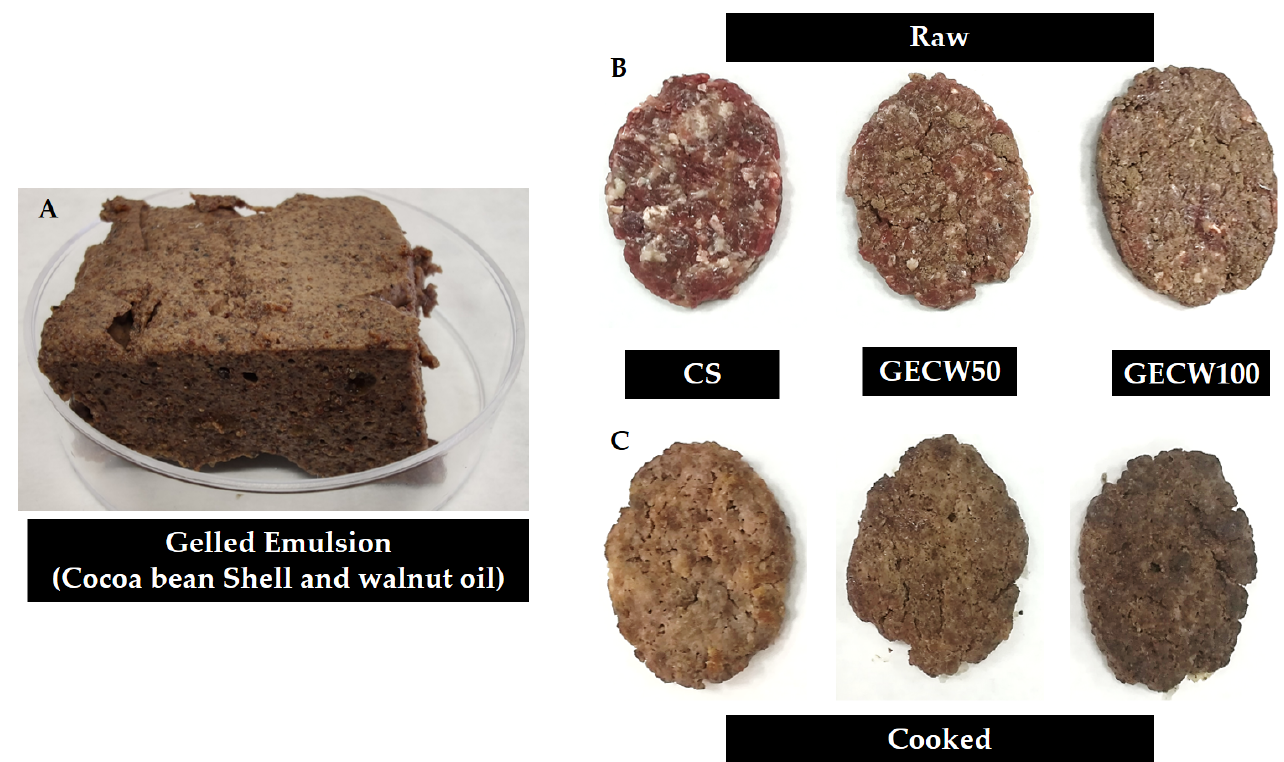
Figure 1. Beef burger made with a gelled emulsion as partial or total pork backfat replacer. ( A ): Gelled emulsion created with cocoa bean shell flour and walnut oil (GECW). ( B ): Raw burger made with 0% (CS: Control sample), 50%, and 100% GECW as fat replacer. ( C ): Cooked burger made with 0%, 50%, and 100% GECW as fat replacer.